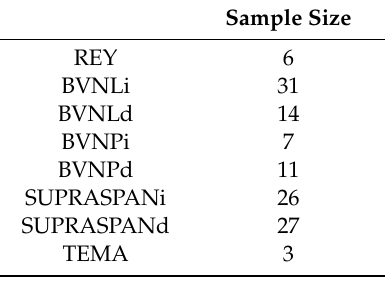
Table 4. Calculation of the sample size for the neuropsychological tools. Alpha is set to 0.05 and power at